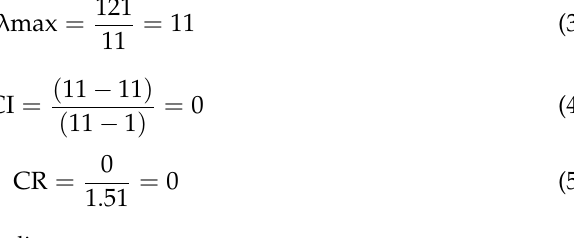
Table 2. Pair-wise matrix of the eleven indices.